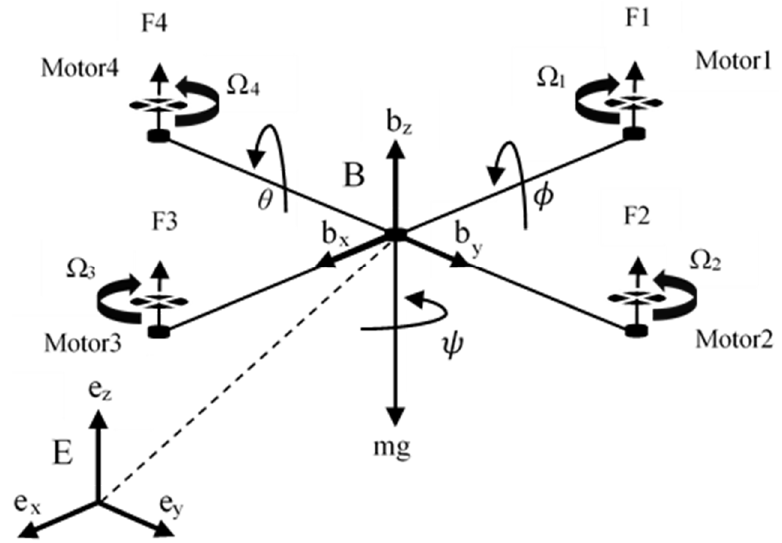
Figure 1. Quadrotor model with reference frames.